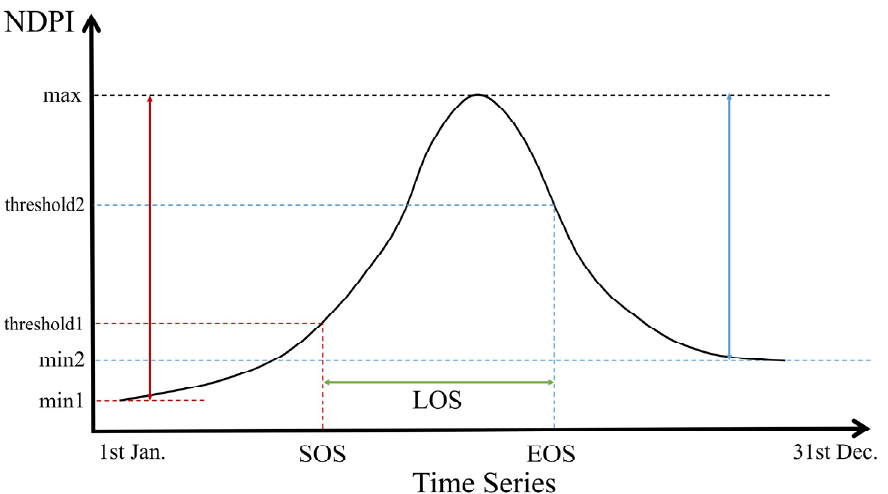
Figure 4. Schematic illustration for extracting LSP metrics using dynamics threshold method. The black curve represents the interannual NDPI for a given pixel. Red lines represent SOS, blue lines represent EOS and green lines represent LOS.